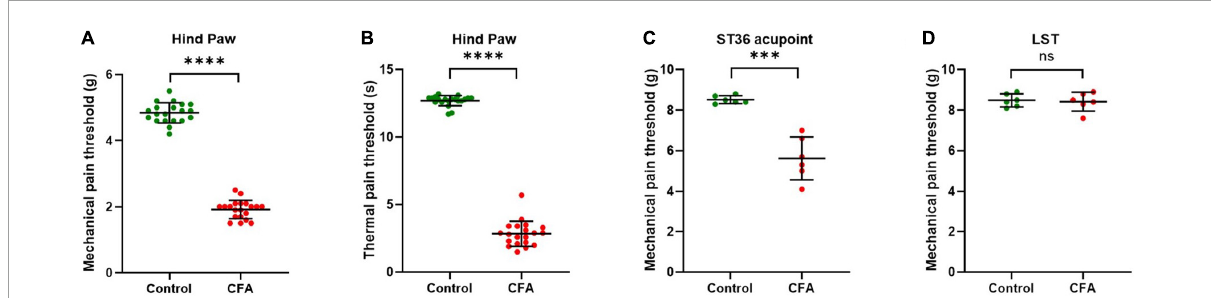
FIGURE1 ST36 acupoints were sensitized in CFA model mice. (A) The mechanical pain threshold of the hind paw decreased in the CFA model. n = 20, ∗∗∗∗ P < 0.0001, paired t -test. (B) The thermal pain threshold of the hind paw decreased in the CFA model. n = 20, ∗∗∗∗ P < 0.0001, paired t -test. (C) The mechanical pain threshold of ST36 acupoints decreased in the CFA model. n = 6, ∗∗∗ P = 0.0009, paired t -test. (D) The mechanical pain threshold of LST did not change significantly in the CFA model. n = 6, P = 0.7412, paired t -test. LST, the position 5 mm lateral side of the ST36.